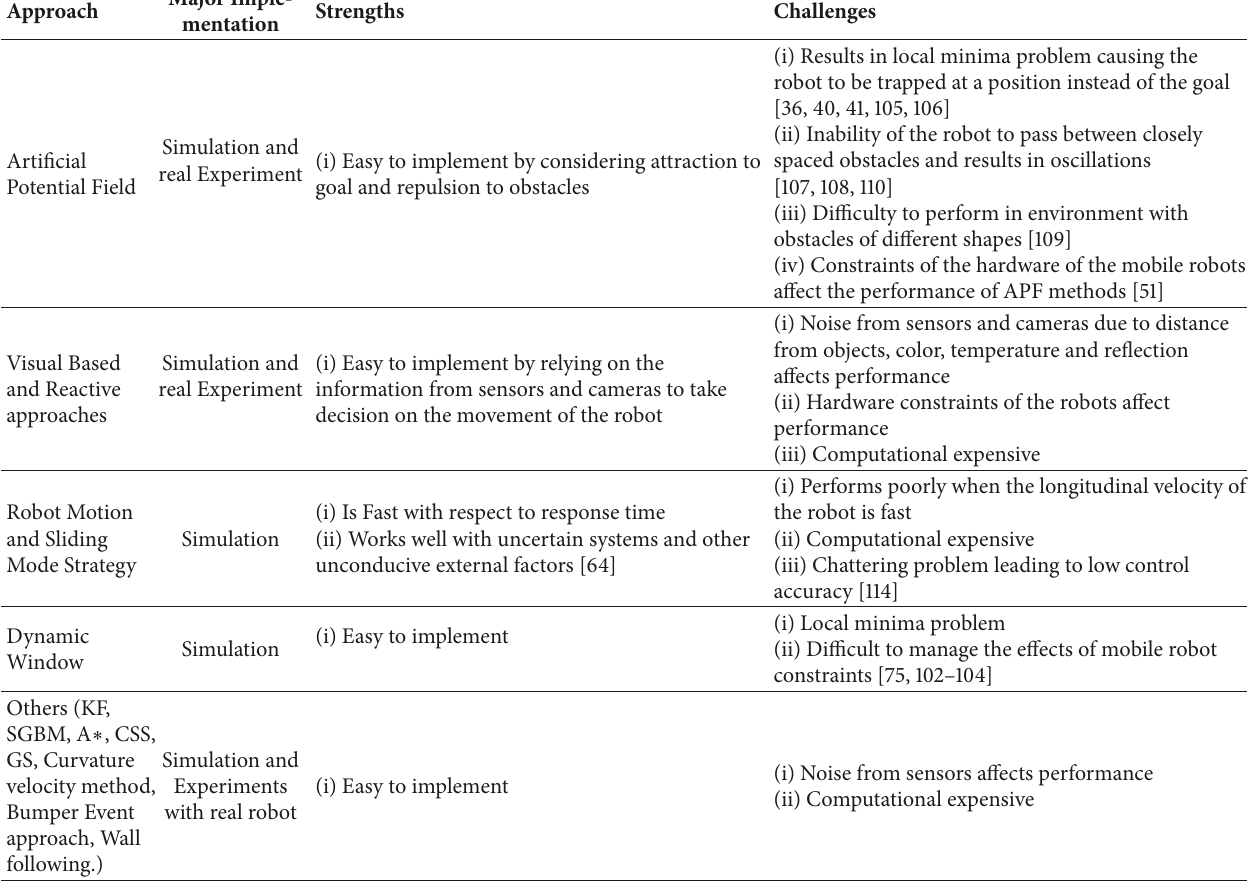
Table 2: Summary of strengths and challenges of conventional based mobile robot path planning and obstacle avoidance methods. Approach